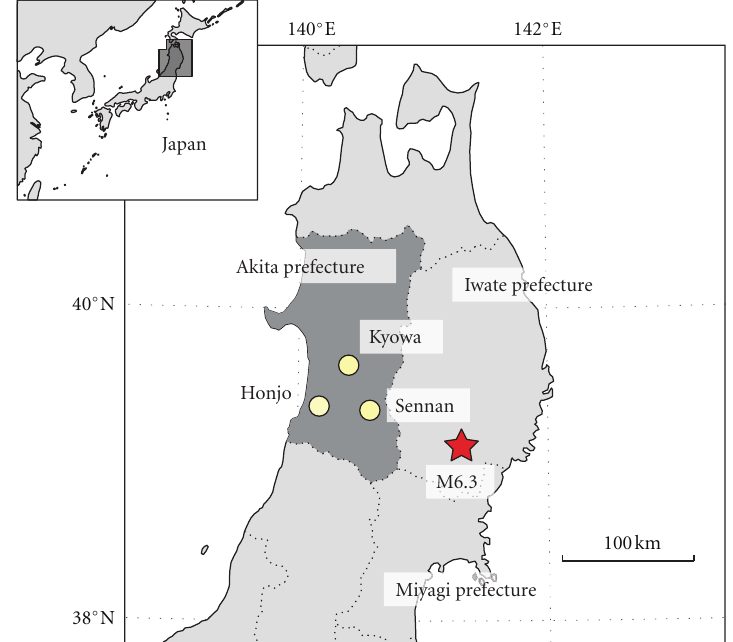
Figure 1: Location of three observation sites (Honjo, Kyowa, and Sennan) and the epicenter of an earthquake (M6.3) in northeastern Japan.